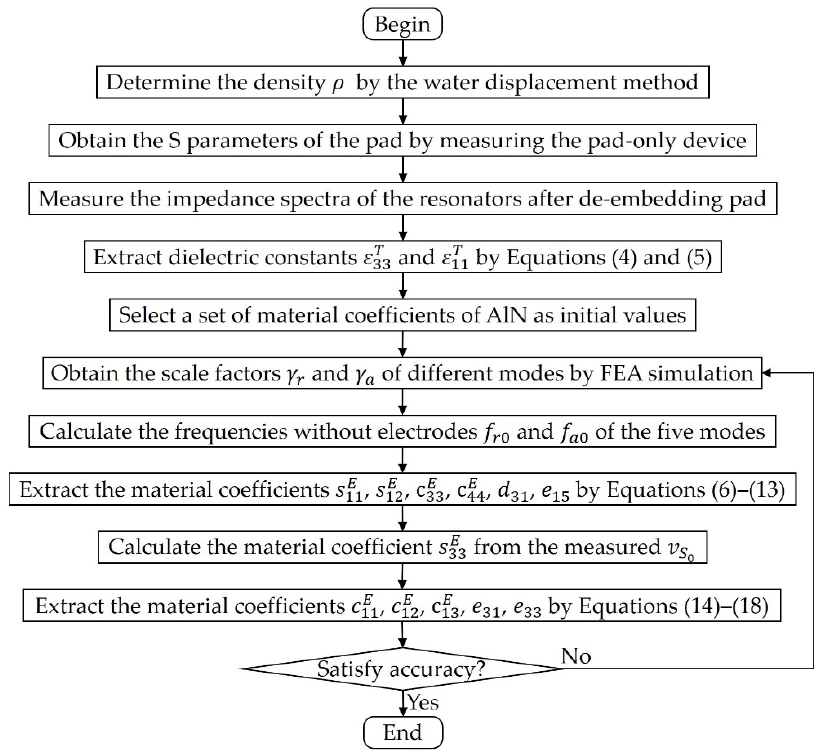
Figure 3. The schematic diagram of the process to extract material coefficients of the AlN thin film.